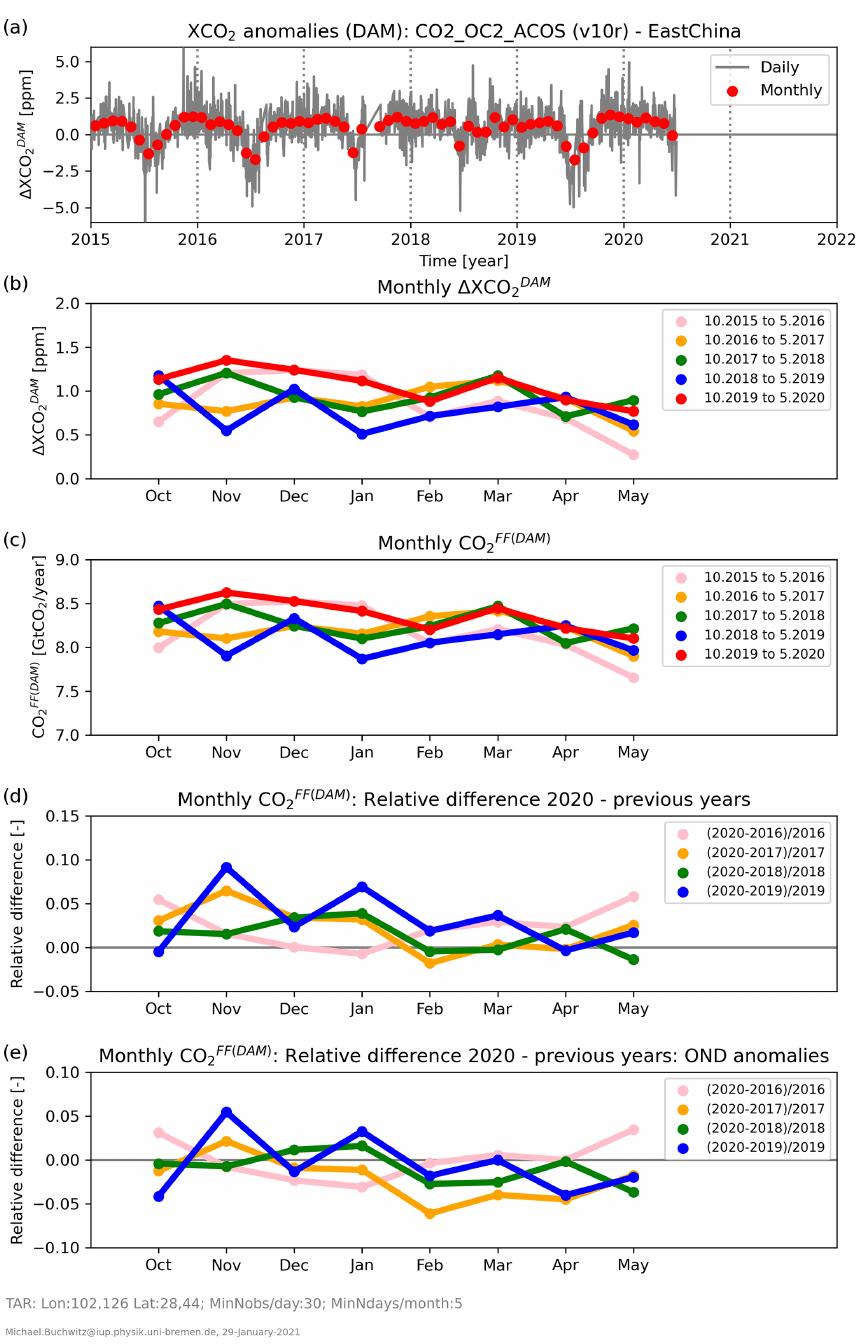
Figure 7. DAM analysis of the OCO-2 ACOS version 10r XCO 2 product (CO2_OC2_ACOS) for the East China region from January 2015 . The red dots are the corresponding to May 2020. (a) The thin grey line shows the daily DAM XCO 2 anomalies, i.e. daily (cid:49) XCO DAM 2 monthly values, which are also shown in panel (b) for different October–May periods. (c) As panel (b) but for CO FF ( DAM ) , i.e. for the 2 estimated East China monthly FF emissions (see main text). The data for October 2019–May 2020 (10.2019–5.2020) are shown in red (see annotation for other periods). (d) Relative CO FF ( DAM ) differences for different periods. In blue, for example, the differences correspond 2 to the period 10.2019–5.2020 (shown in red in panel c ) minus 10.2018–5.2019 (shown in blue in panel c ). (e) As panel (d) but after the October-to-December mean value (OND anomalies). The following parameters have been used to generate this figure: minimum number of observations per day: 30; minimum number of days per month: